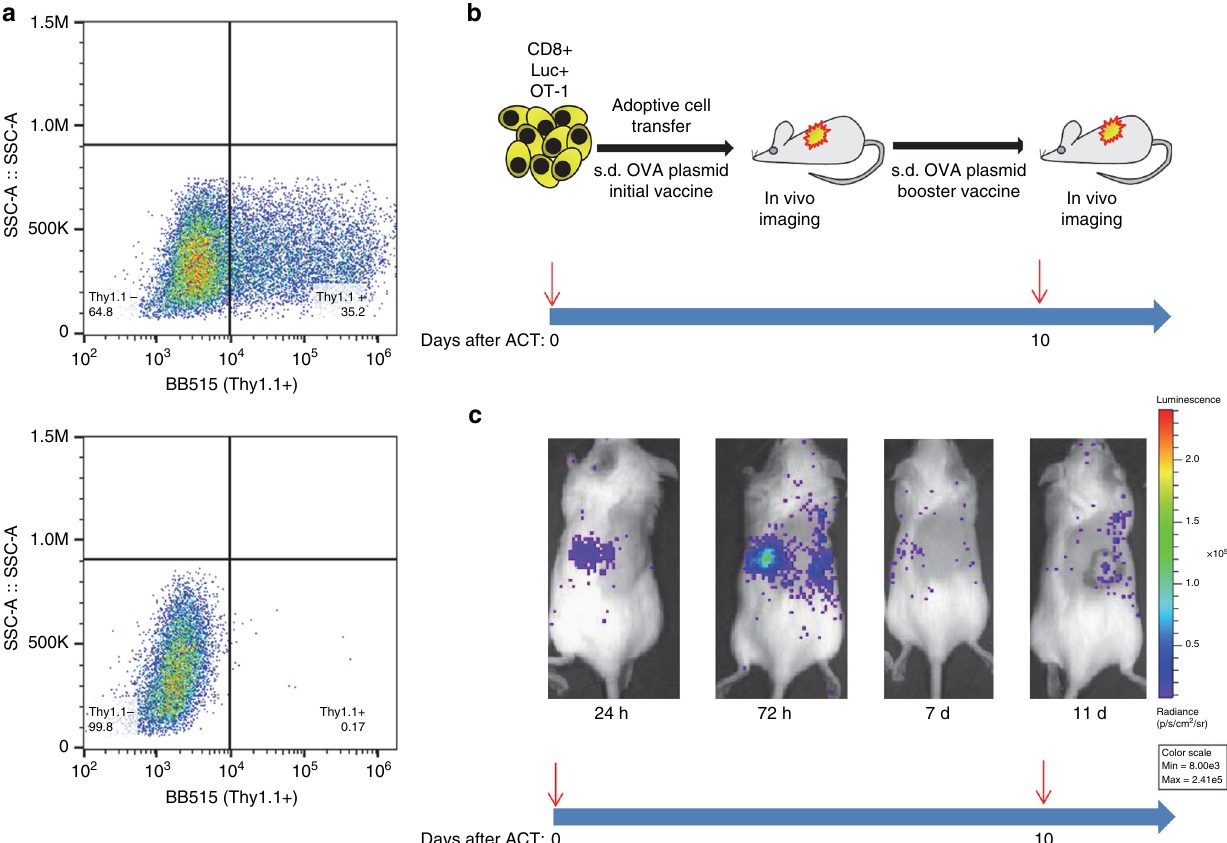
Fig. 2 Transposon modi fi cation and functional engraftment of OT-1 T cells. CD8 + T cells were modi fi ed with the pT-ef fl uc-thy1.1 transposon, and 1 × 10 7 CD8 + T cells were transferred into host mice. a Representative fl ow cytometry analysis (from N = 3) showing ~35% of T cells transfected with pT-ef fl uc- thy1.1 plus pCMV-m7pB were thy1.1-positive after 24 h culture post transfection (top) compared to cells transfected with pTSB-CAG-OVA plus pCAG- SB100X (negative control; bottom). b Schematic representation of experimental design. c Representative bioluminescent imaging ( N = 5) from a mouse subdermally injected with the pTSB-CAG-OVA plasmid vaccine immediately after adoptive cell transfer (ACT) and on day 10 after ACT. The blue arrow timeline indicates the days after ACT. Red arrows indicate vaccine administration immediately after ACT and on day 10 after ACT. The images a –